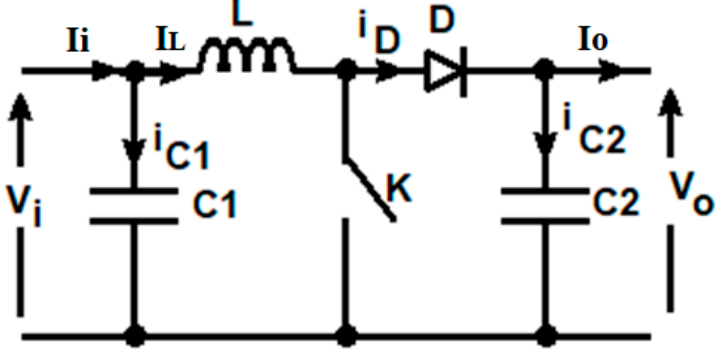
Figure 3. Simplified schematic of a boost